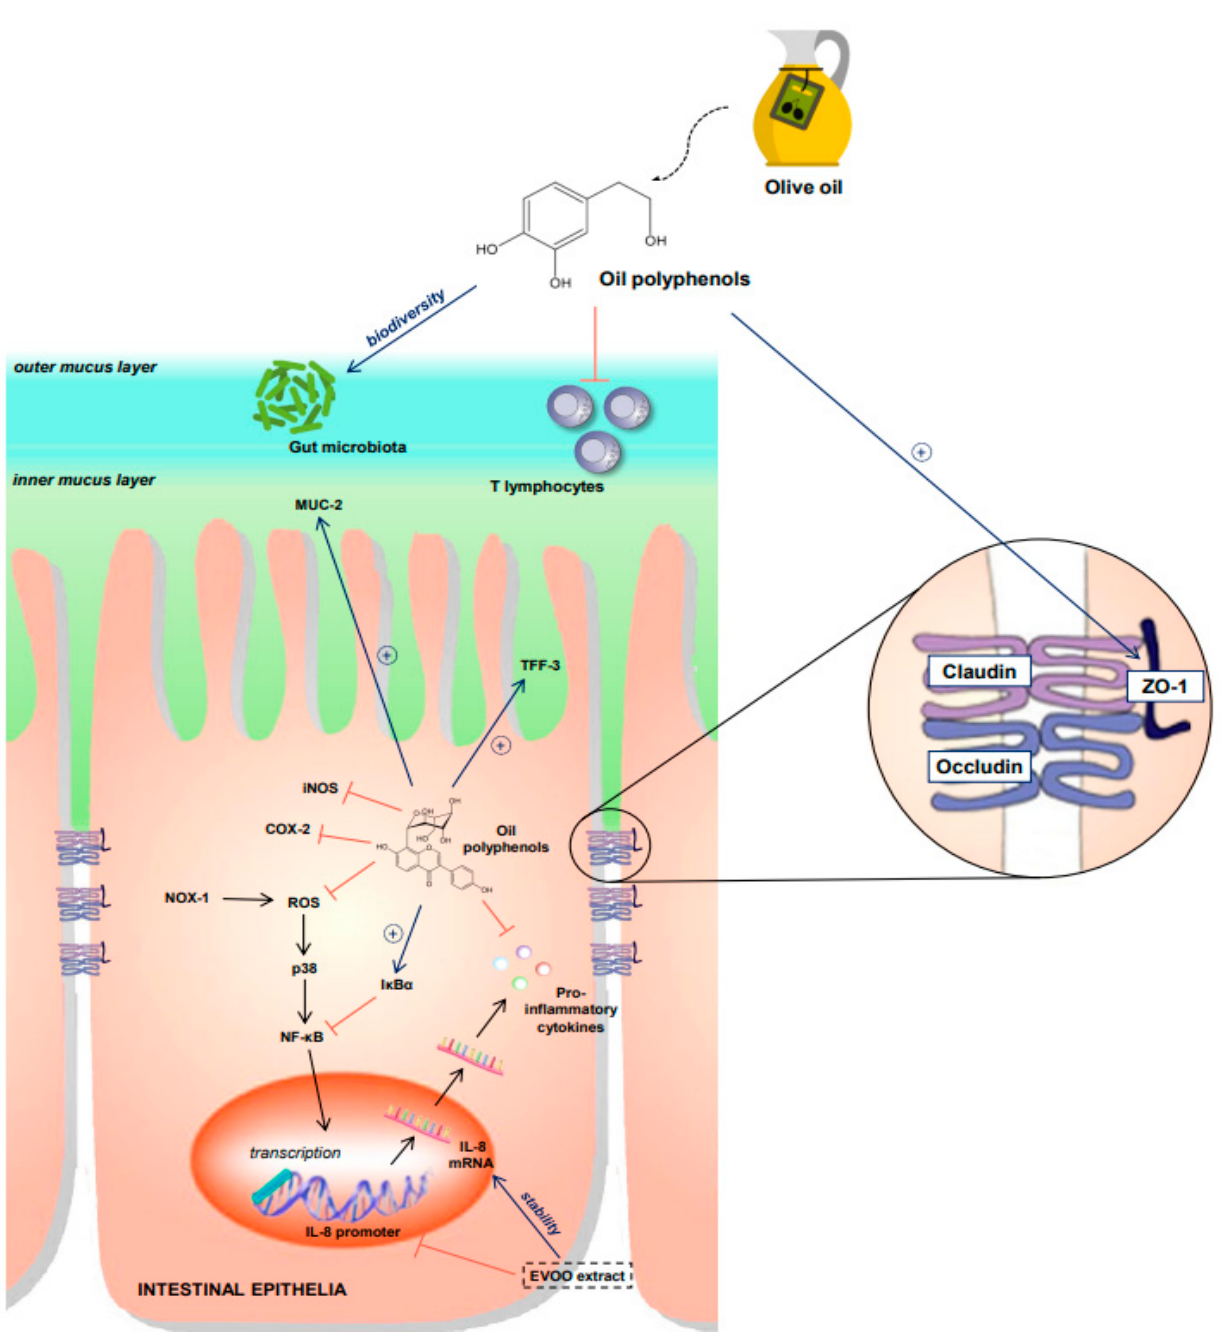
Figure 1. Effects of olive oil polyphenols on intestinal homeostasis as shown by in vitro